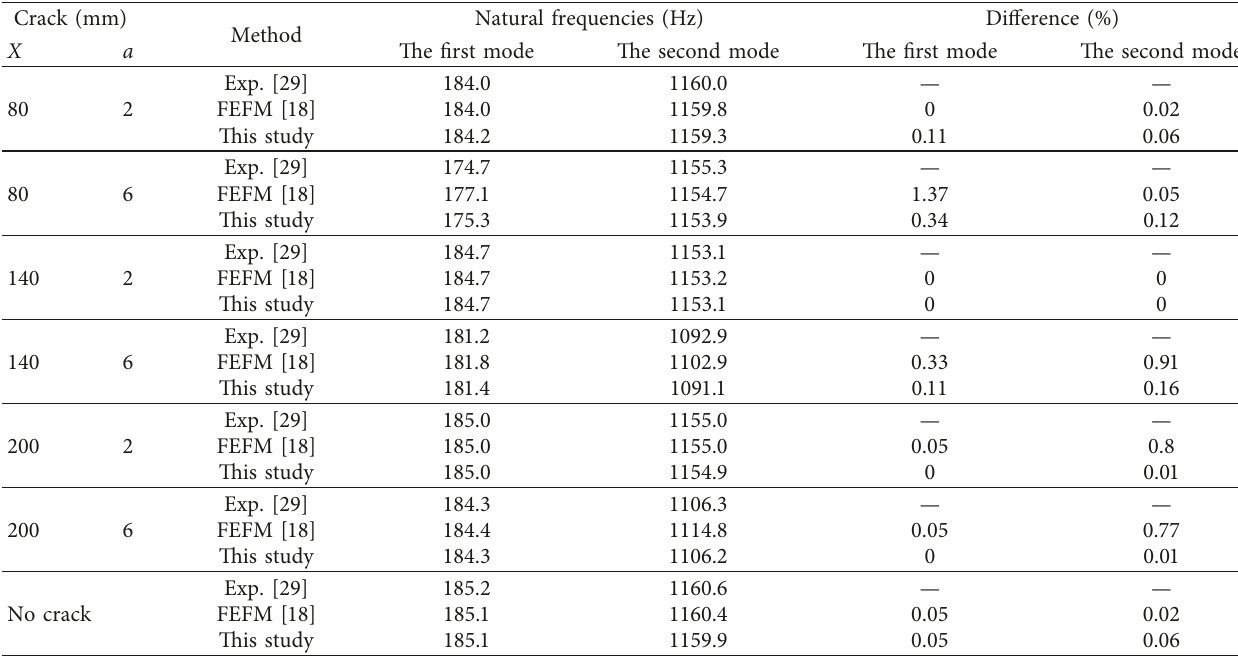
Table 1: Comparisons of the first two natural frequencies from the proposed model, FEFM, and the experimental investigation for a cracked cantilever beam with open crack.